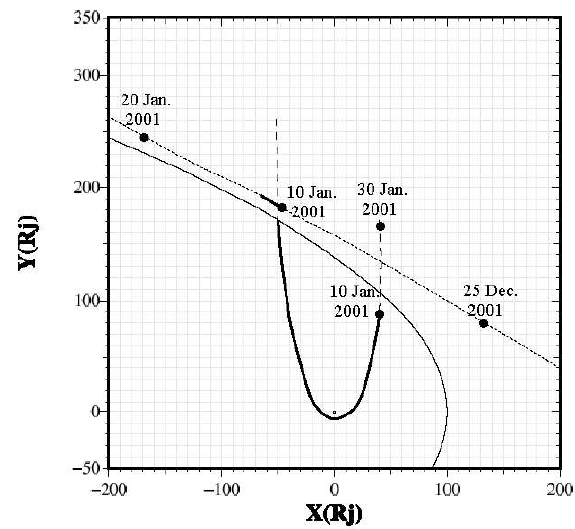
Fig. 1. The trajectories of the Cassini and Galileo during the time interval surrounding Cassini’s closest approach. The coordinate system is centered on Jupiter with the positive X axis directed from Jupiter to the Sun. The Z axis is normal to Jupiter’s or- bital plane with positive north. The Y axis completes an orthog- onal system. The portion of the 28th and 29th Galileo orbits is shown. The portions of the orbits which correspond to the time in- tervals when the spacecraft were in the magnetosphere are marked by heavy curves. The magnetopause calculated in the paraboloid model is also shown. On the evening at 10 January 2001 both spacecraft crossed the magnetopause roughly simultaneously (with about 20min delay). At this time Galileo was placed at x =+ 50 R J and Cassini was located at x =− 50 R J . The magnetopause crossing points were determinated by Kurth et al. (2002). Small, solid cir- cles mark the beginning of the days: 25 December 2000, 10 January 2001, and 20 January 2001 on the Cassini trajectory, and 10 January 2001 (when both spacecraft crossed magnetopause), and 30 January 2001 on the Galileo